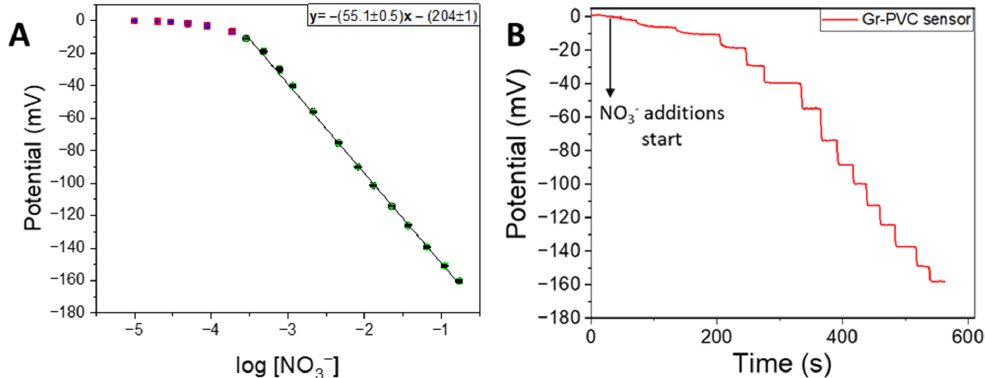
Figure 2. Electroanalytical characterization of the sensor towards NO 3 − ions through calibration procedure. ( A ) Representation of the potential as a function of log NO 3 − concentration. The red squares are out of the linear range (sub-Nernstian response zone), and the other data points are fitted linearly to obtain the sensor sensitivity (Nernstian response zone). ( B ) Graph of potential against time as NO 3 − stock addition, visible as potential steps, was performed.